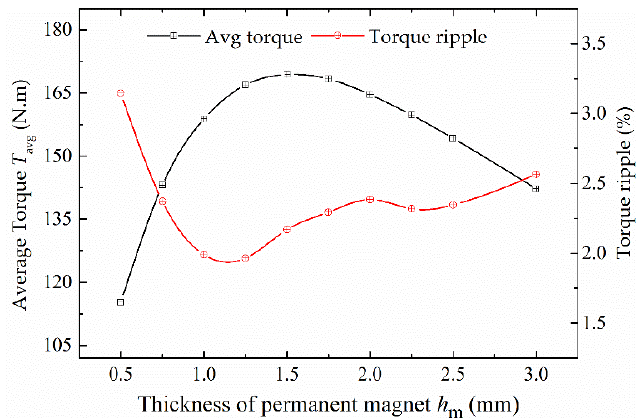
Figure 12. The influence of permanent magnet thickness h m on average torque and torque ripple.